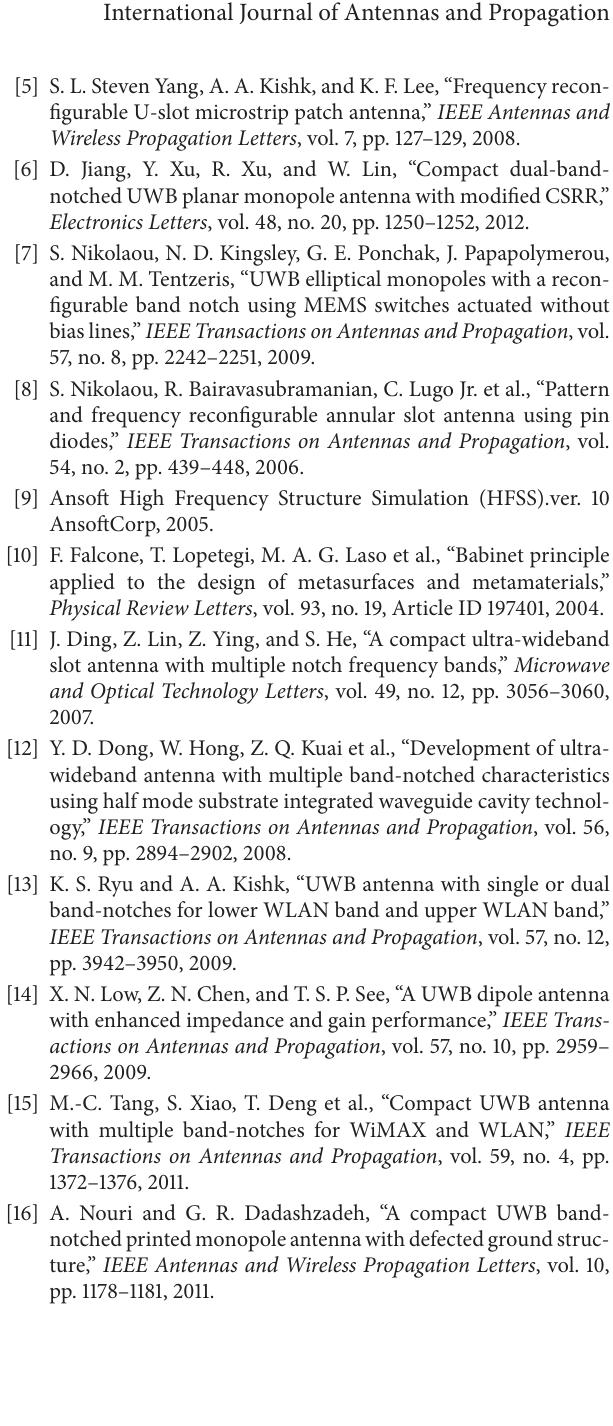
figurable U-slot microstrip patch antenna,” IEEE Antennas and